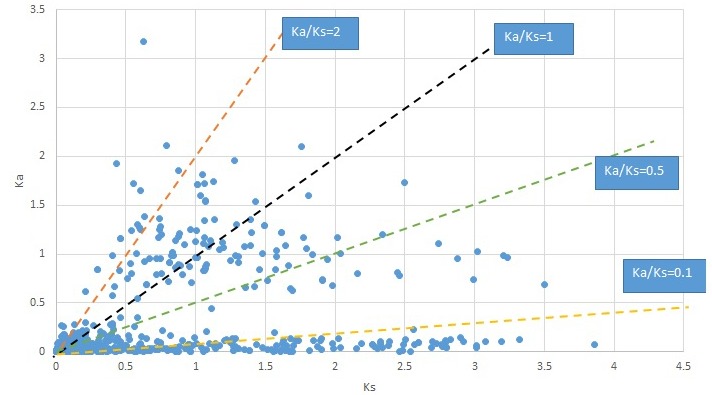
Plot of Ka and Ks values for each POG in 20 taxon pairs, in alphabetical order of genus names.Cornus-2.